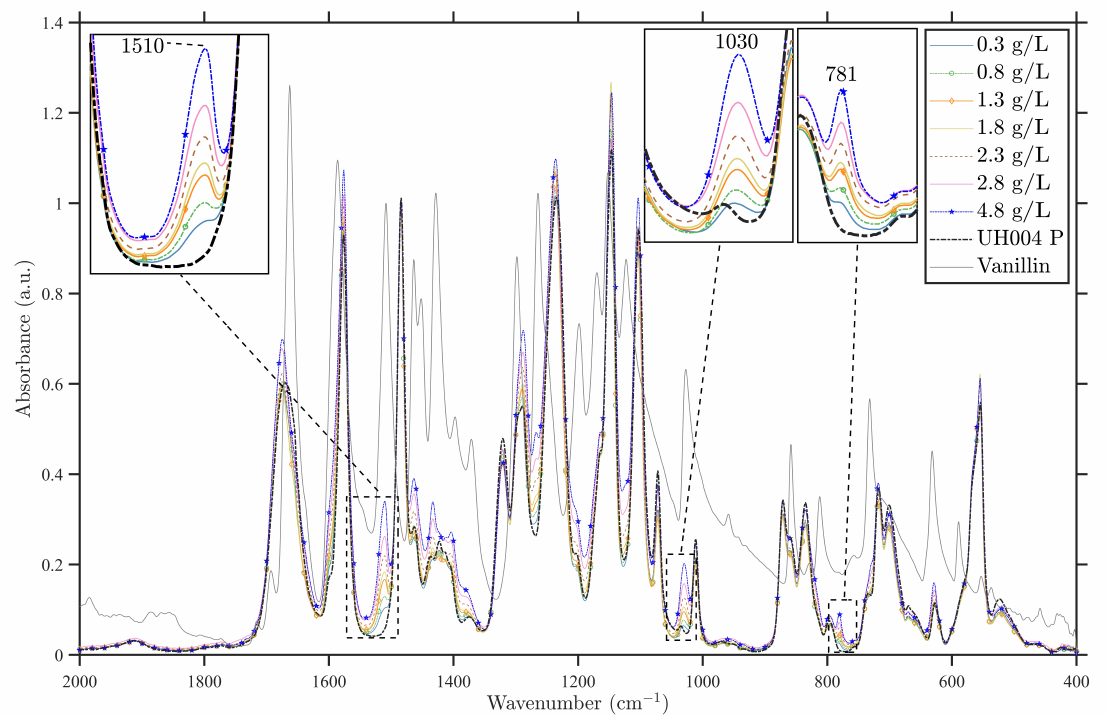
Figure 4. FTIR spectra of virgin and modified UH004 P membranes for various concentrations in the region of 2000–400 cm − 1 . The peaks corresponding to the presence of vanillin can be distinguished at 1510, 1030 and 781 cm − 1 .